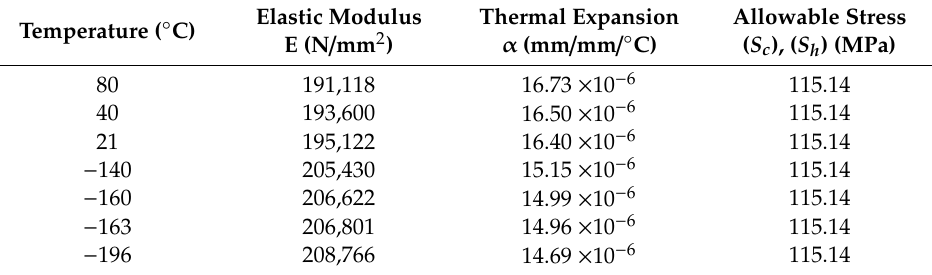
Table 1. Material property of stainless-steel pipe.